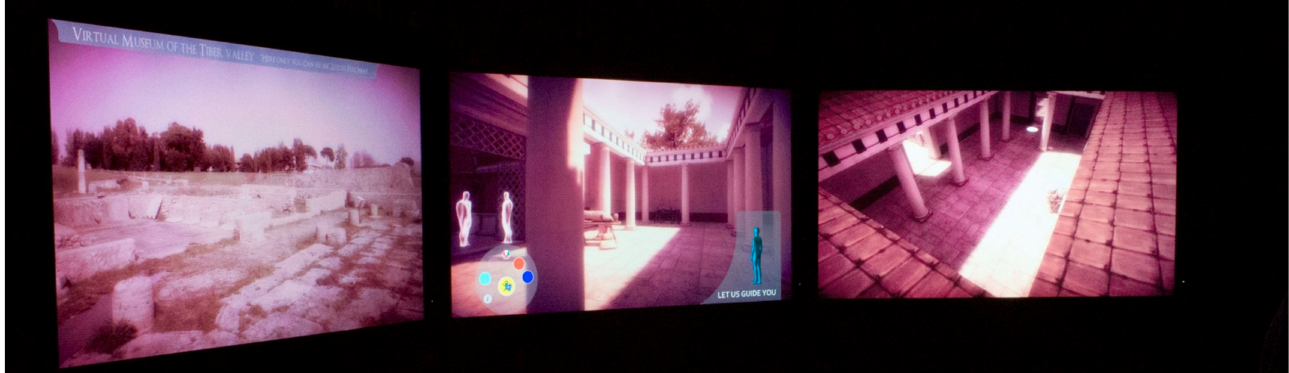
Figure 7. Virtual reality scenario dedicated to Lucus Feroniae. The Basilica is shown on three screens. ( Left ) the actual archaeological site. ( Center ) the virtual reconstruction seen from the same point of observation. ( Right ) a farther view where the user’s position, represented by a white circle, can be recognized.